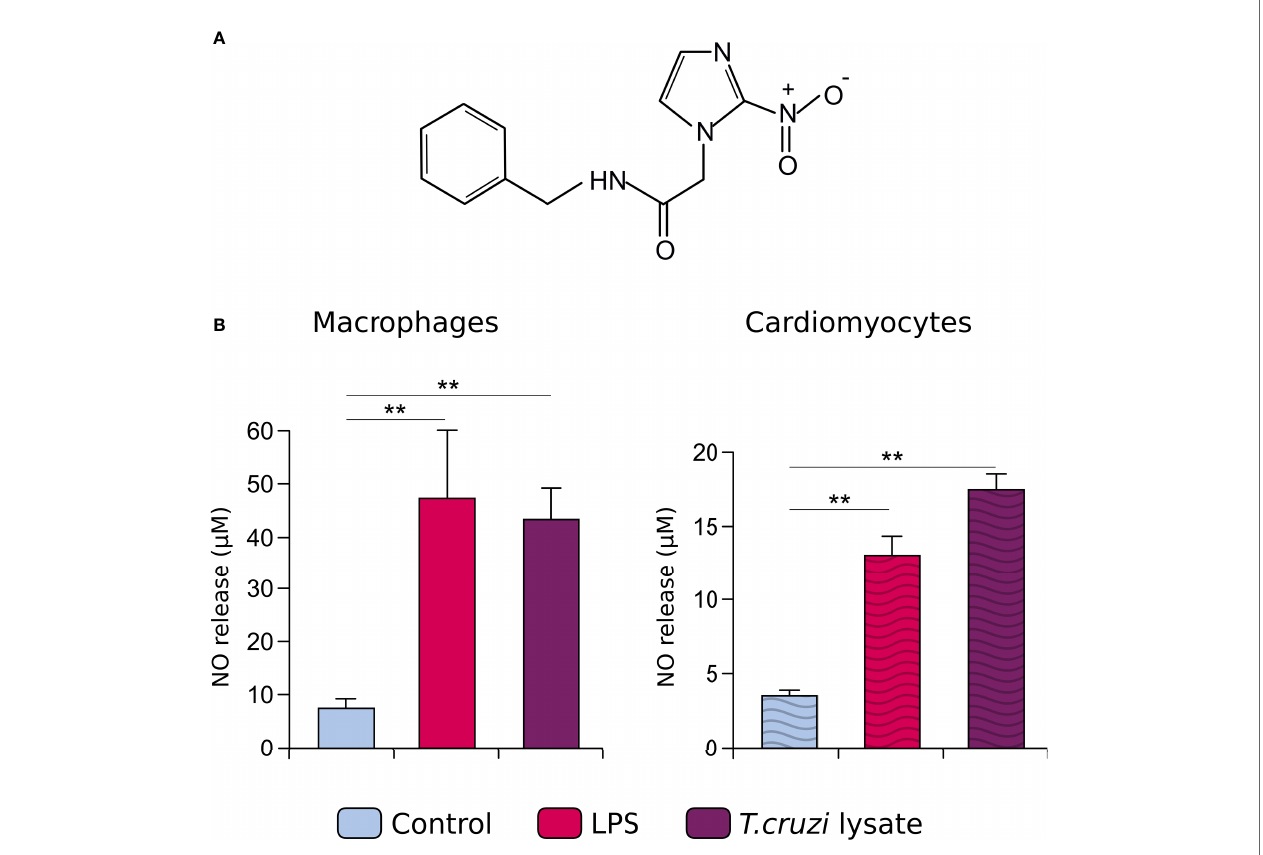
FIGURE 1 | The chemical structure of benznidazole (Bzl), the drug used in this study is shown (A) . RAW 264.7 macrophages and neonatal primary cardiomyocytes were treated with 15 µM of Bzl for 30 minutes and then with 10 µg/mL of LPS or 10 µg/mL of T. cruzi lysate. After 48 h, NO levels were quanti fi ed by the Griess reaction in culture supernatants (B) . Results are expressed as the mean of 3 independent experiments (n=3, 5 replicates/treatment) ± SEM. ** P < 0.001 vs . control